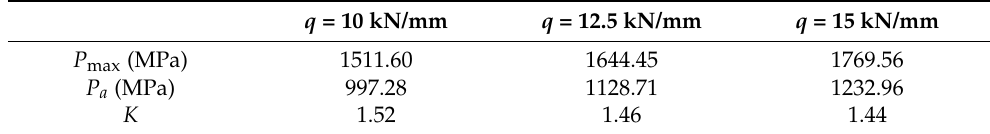
Table 2. The coefficient K at different strip widths B .